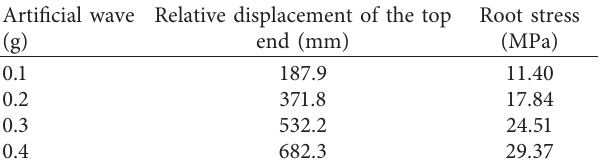
Table 7: Shaking table test results of ± 1,100 kV composite pillar insulators.